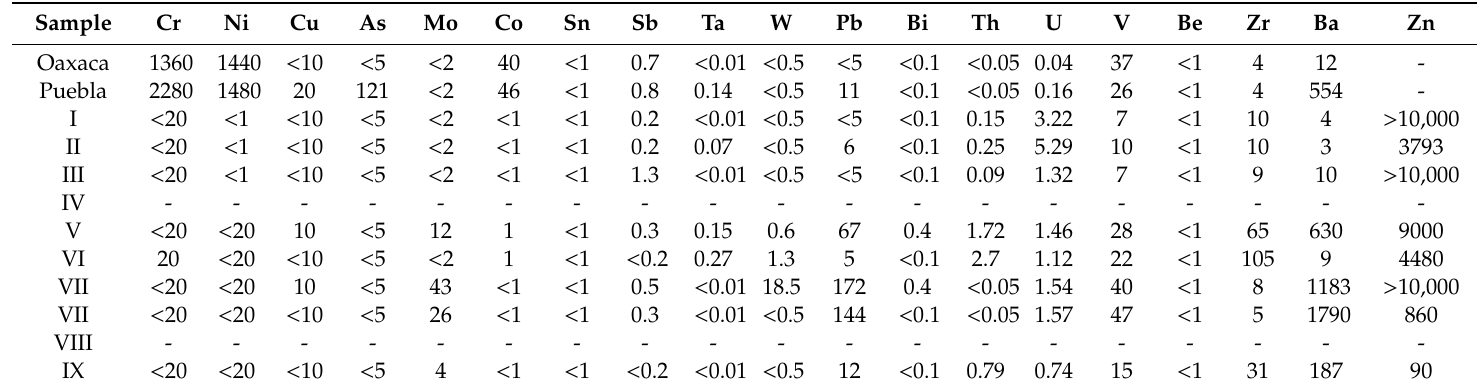
Table 6. Minor element composition (ppm) of natural Mexican talc from Oaxaca and Puebla ore deposits and high and low-priced packed products, determined by ICP-MS. The zinc content is related to the presence of the mineral zincite that is used as a colorant in the packaged